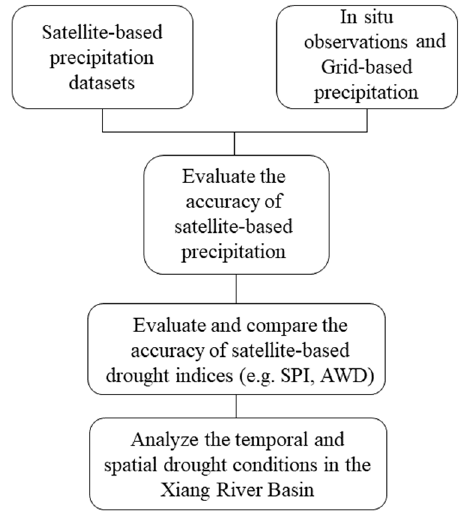
Figure 3. The flow-chart of the main steps of the F igure 3. The flow-chart of the main steps of the study.